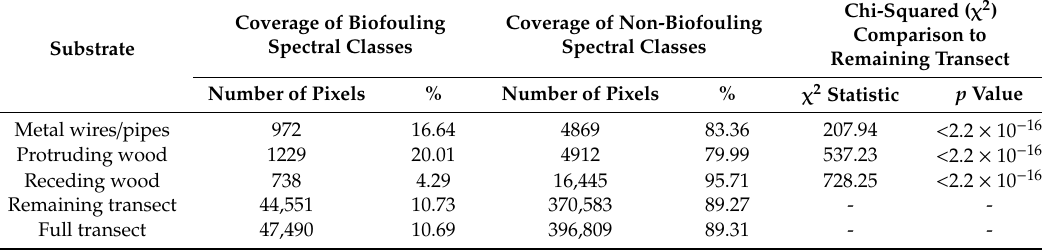
Table 3. Estimated areal coverage (number of pixels and %) of biofouling and non-biofouling spectral classes in four discrete subset areas of the underwater hyperspectral imaging (UHI) transect corresponding to metal wires / pipes, protruding wood, receding wood and the remaining transect. The table also shows the equivalent estimates for the full transect. The final two columns show the results of chi-squared ( χ 2 ) comparisons of biofouling vs. non-biofouling pixel coverage in archaeological subset areas (metal wires / pipes, protruding wood, and receding wood) vs. the remaining